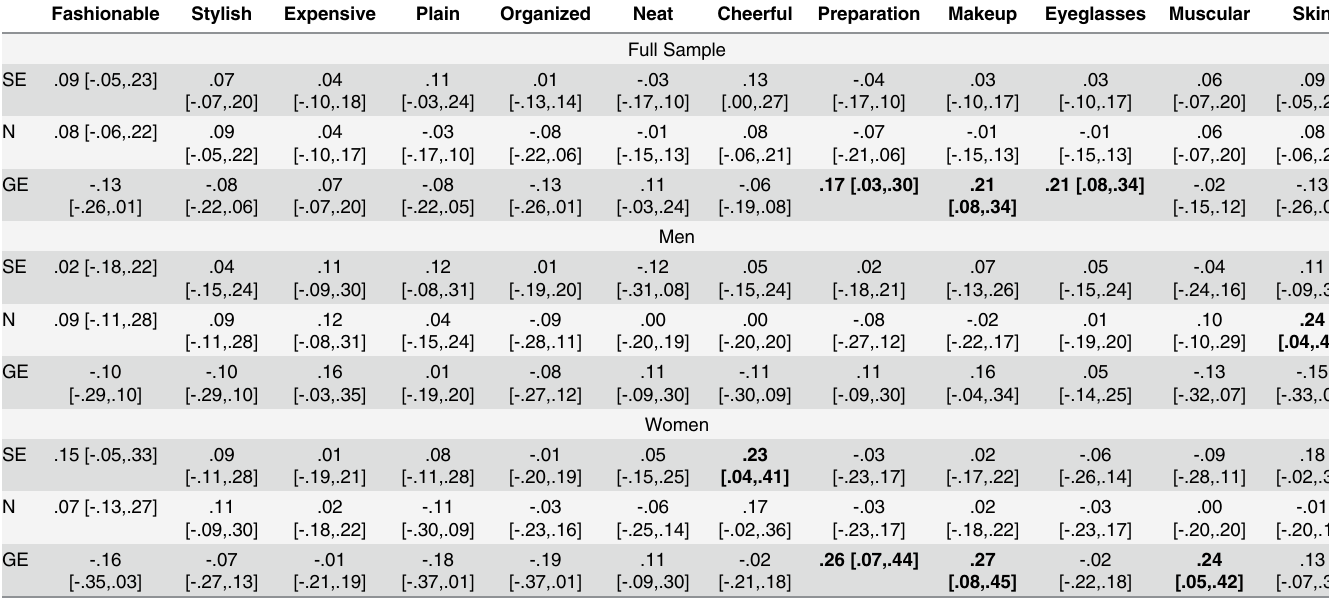
Table 5. Correlations between Ratings of Dragon * Con photographs Based on Vazire et al. (2008) and Self-esteem, Narcissism, and Geek Engagement. Fashionable